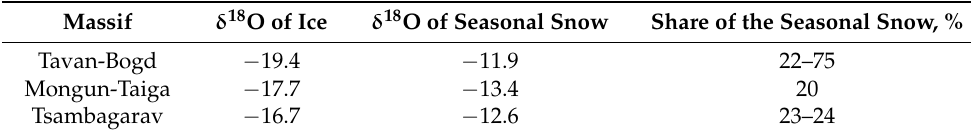
The results of isotopic separation prove suggestions from Section 4.3 of this article: seasonal snow from the surface of glaciers has more of a significant influence on glacier runoff in the Tavan-Bogd massif. The main reasons for this are the better conditions for accu- mulation of summer snow, according to the widespread occurrence of small corrie